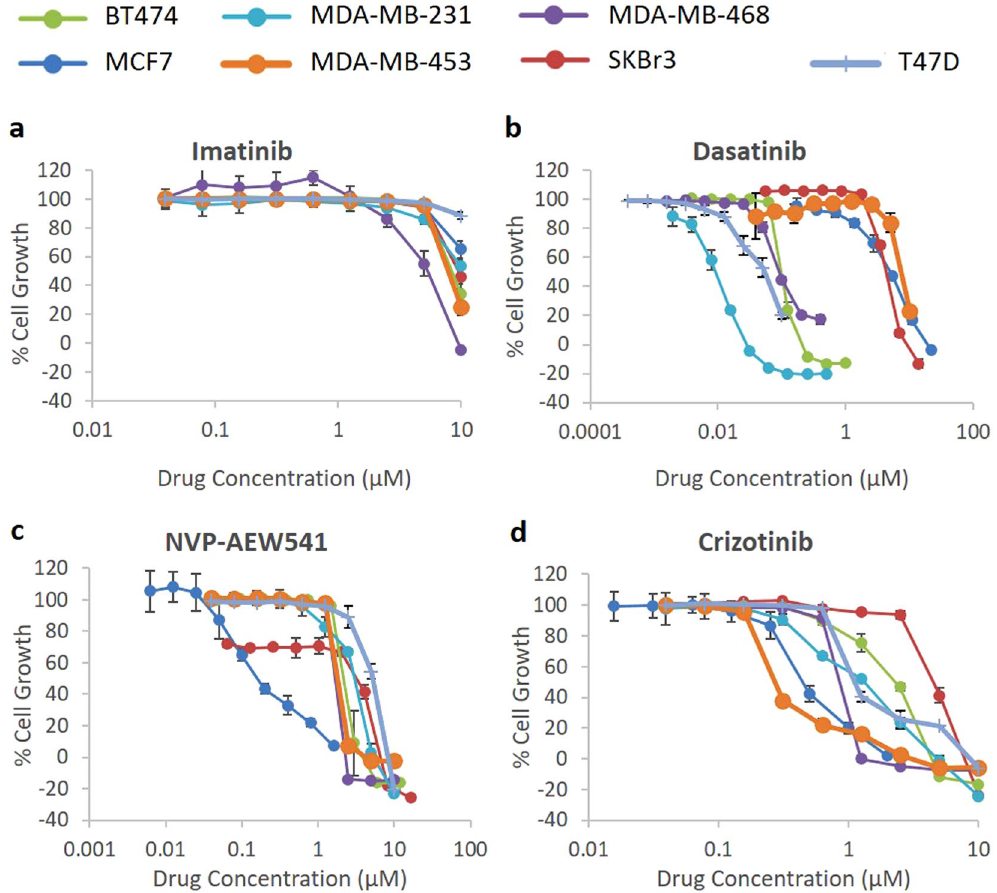
Figure 3. Growth control graphs showing effect of selected TKIs in doubling concentrations on growth of breast cancer cell lines. ( a ) BCR-Abl/c-Kit inhibitor imatinib. ( b ) BCR-Abl/Src inhibitor dastinib. ( c ) IGF-1R inhibitor NVP-AEW541. ( d ) C-Met/ALK inhibitor crizotinib. Sulforhodamine B colorimetric assay was used to determine the effect of treatment of breast cancer cell lines with doubling dilutions of selected TKIs. Imatinib was relatively ineffectual at inhibiting growth in our panel of cell lines, while the effects of dasatinib ranged from moderate (MCF7, IC50 = 4.95 µ M) to very high (MDA-MB-231, IC50 = 9 nM). NVP-AEW541 and Crizotinib had moderate growth inhibitory effects in all cell lines, ranging from 0.14–5.27 µ M and 0.40–4.61 µ M, respectively. Each point is a representative of the mean ± SD of triplicate